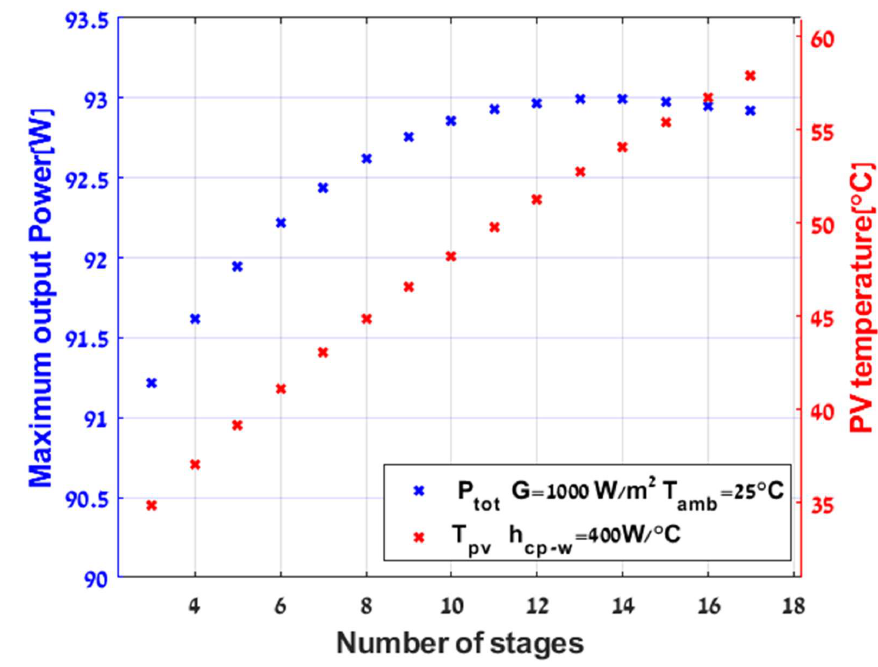
Figure 10. Maximum output power as a function of variable TEG stages.